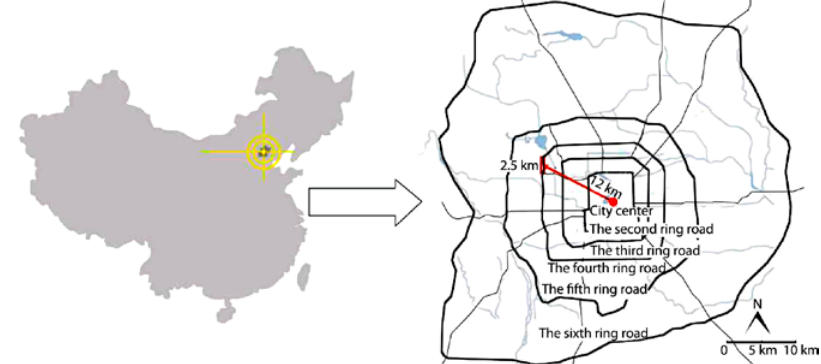
Fig. 1. Location of six green belts along the west Fourth Ring Road of